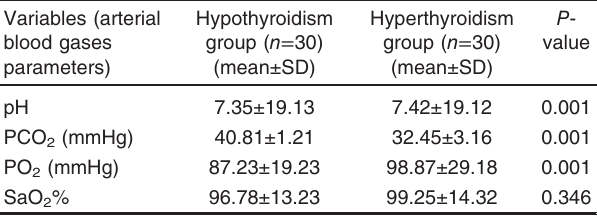
Table 9 Comparison of arterial blood gases parameters between hypothyroid and hypothyroid groups Variables (arterial blood gases